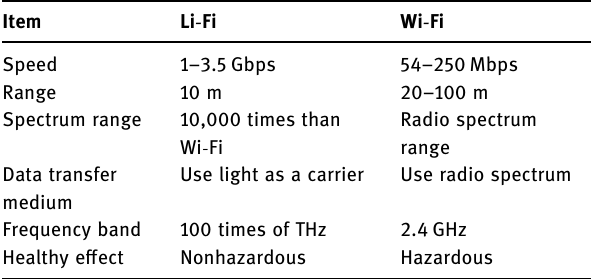
Table 4: Comparison between Li - Fi and Wi - Fi technologies [ 57 ]